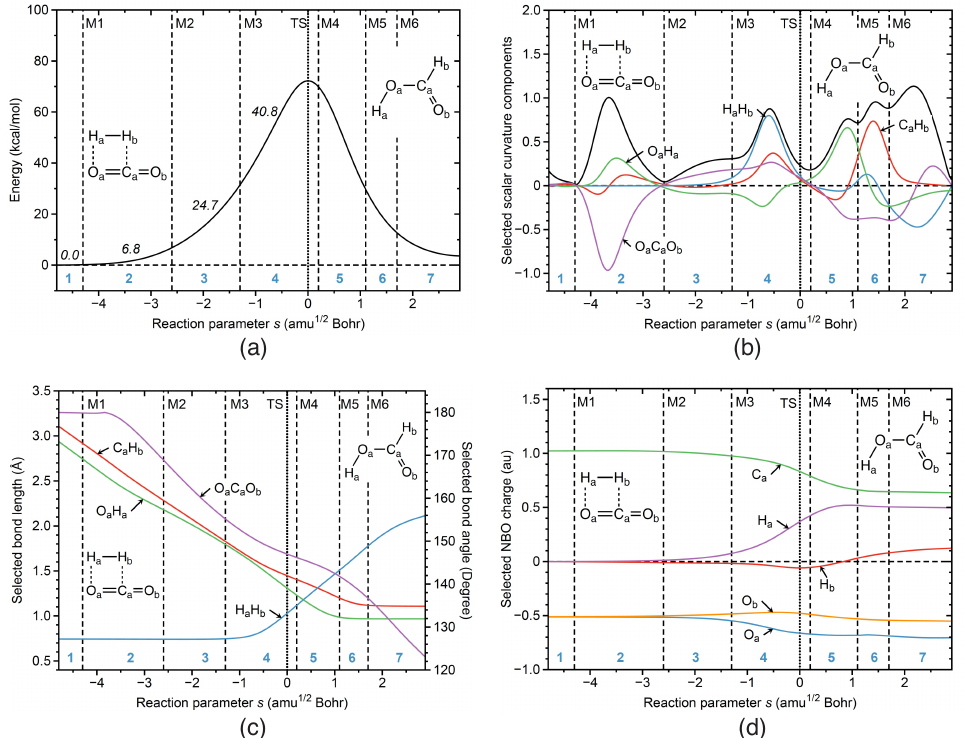
Figure 4. Properties of the gas phase reaction R0 along the reaction path. ( a ) Energy profile, energy contributions of each reaction phase to the activation energy are indicated by italic numbers; ( b ) de- composition of the reaction curvature into selected components; ( c ) change of selected bond lengths along s ; ( d ) change of selected NBO atomic charges along s . Positions of the curvature minima are shown as dashed vertical lines and are labeled as M1, M2, and so on. The position of the TS is indi- cated by a dotted line. Reaction phases are indicated by blue numbers. B3LYP/6-31G(d,p)/SDD(Ir) level of